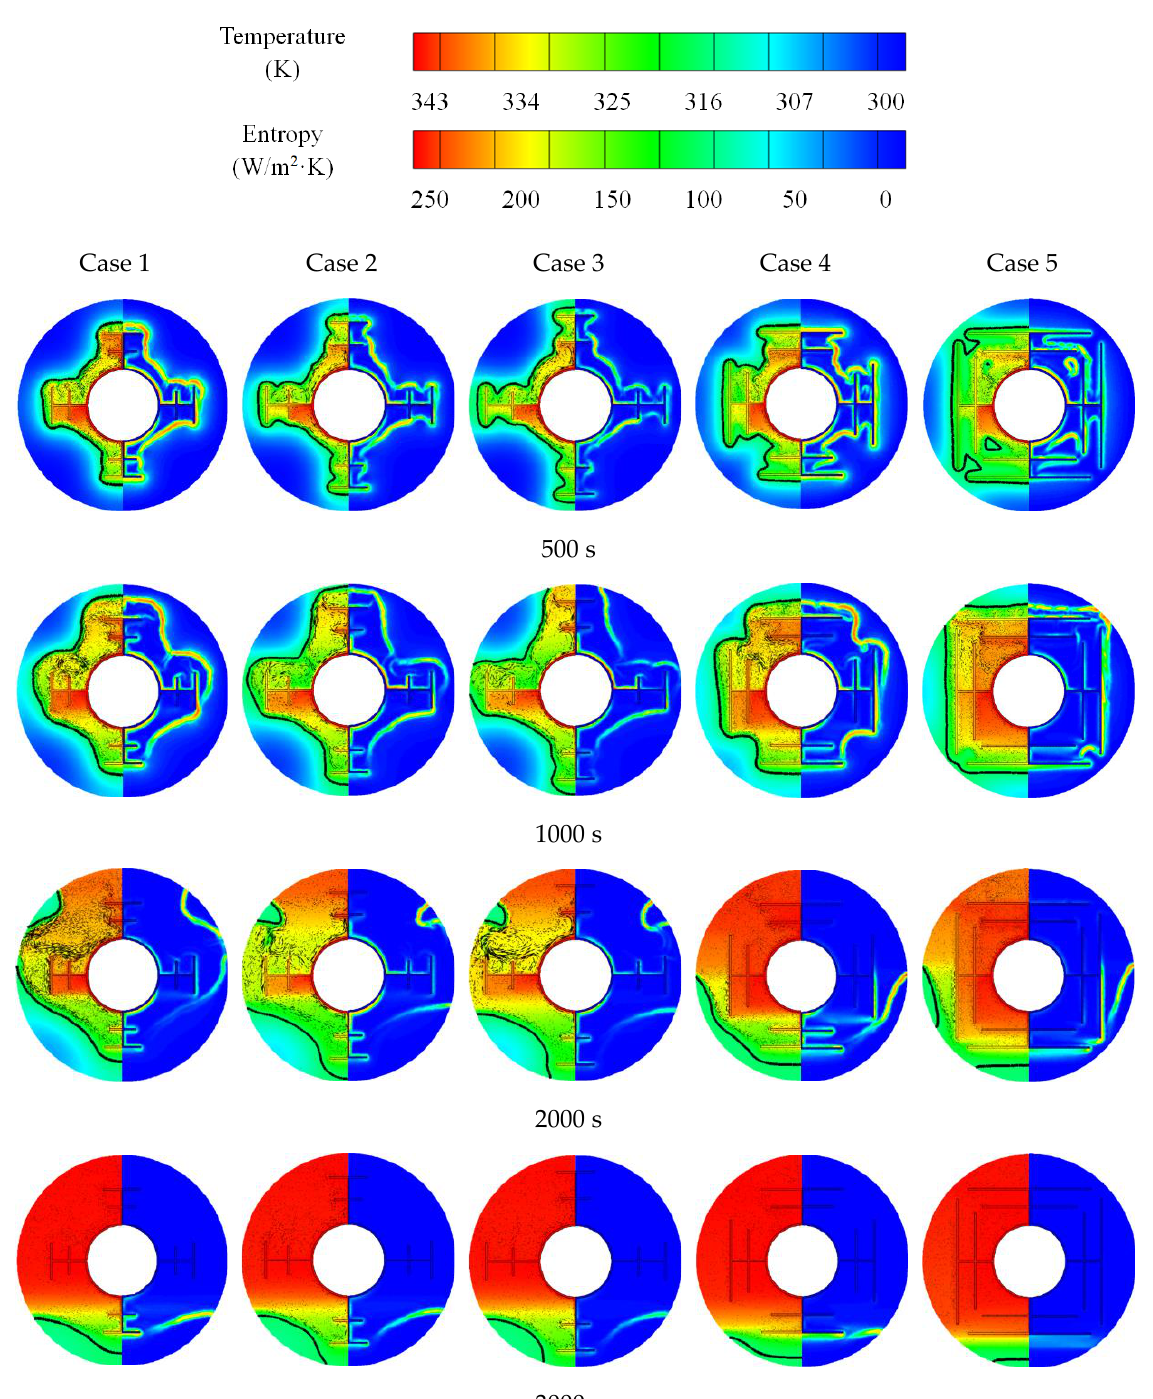
Figure 11. Melting process for Cases 1 – 5.